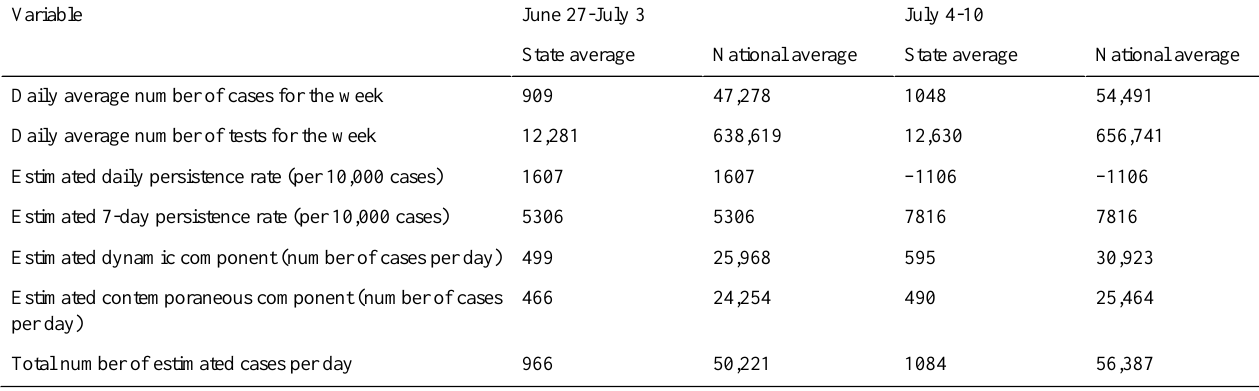
Table 2. Dynamic panel data estimation results for the United States from June 27 to July 10,